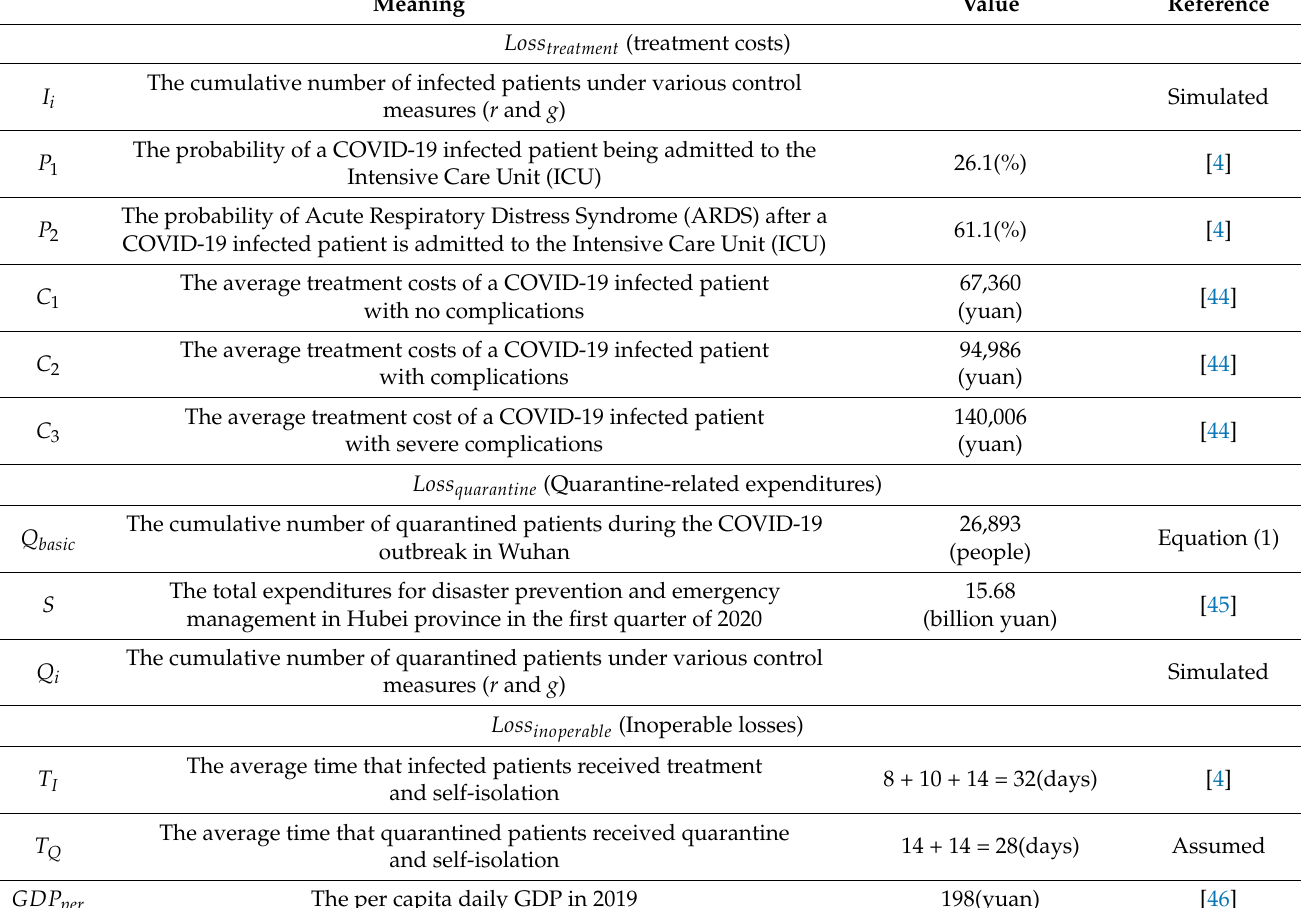
Table 2. Parameters of estimating the first three parts of economic